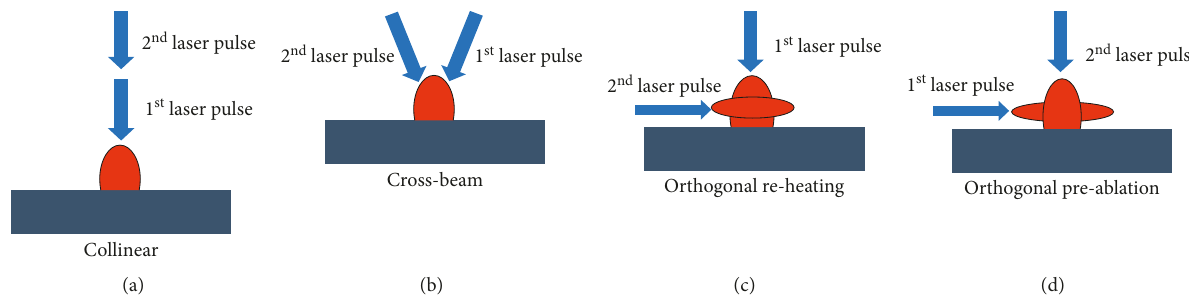
Figure 2: Four different DP LIBS configurations: (a) collinear, (b) cross-beam, (c) orthogonal reheating, and (d) orthogonal preablation (redrawn from [20]).